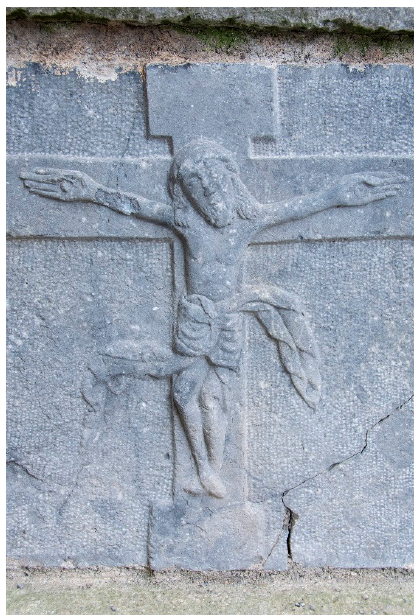
Figure 19. Tomb of Walter Brenach and Katherine Poher, Jerpoint Abbey, Co. Kilkenny, c.1501. Pho-